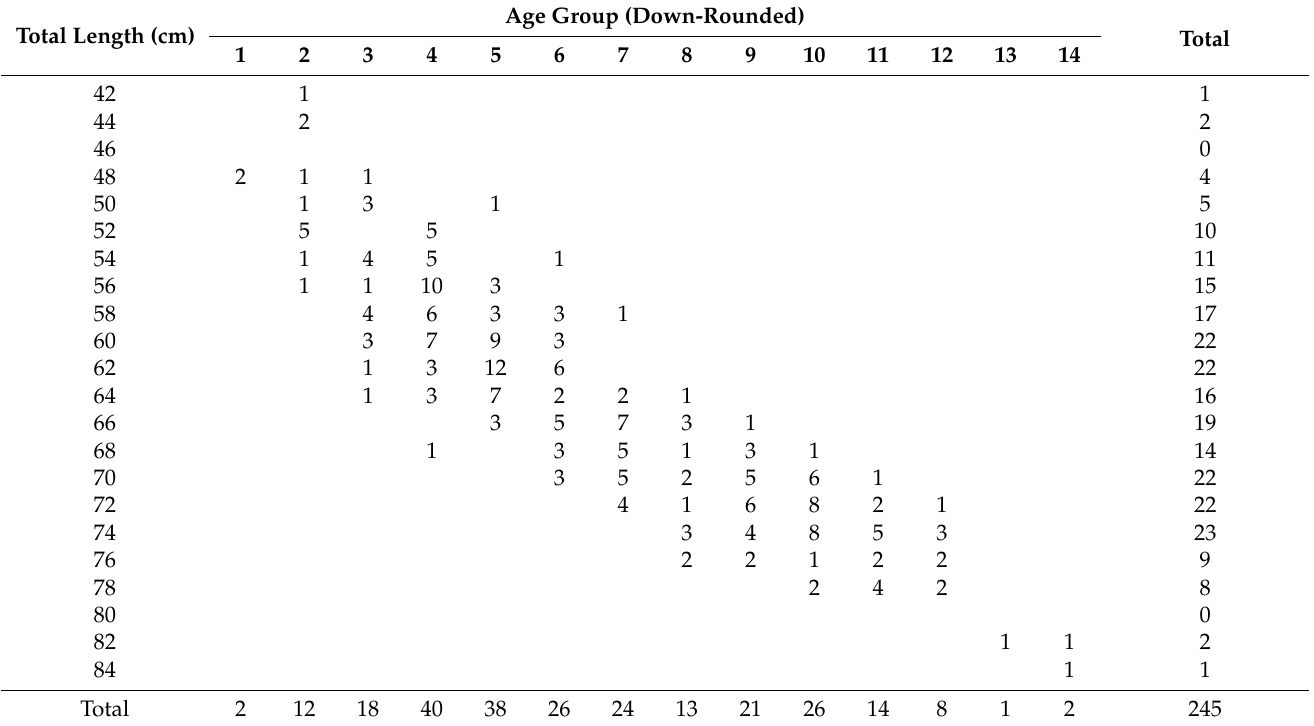
Figure 4. Monthly variations in vertebra edge and marginal increment ratios (MIR). Monthly frequency of translucent ( □ ) and opaque bands ( ■ ) determined from thin sections and monthly variation of mean MIR. Sample size is indicated on top of the graph; ( ▪ ) mean monthly MIR; bars show the standard error for monthly values. Table 2. Age–length distribution for Narcine entemedor obtained from growth band counts of vertebrae sections. Age estimation follows the age adjustment 2 (adjusted to reproductive cycle and date of